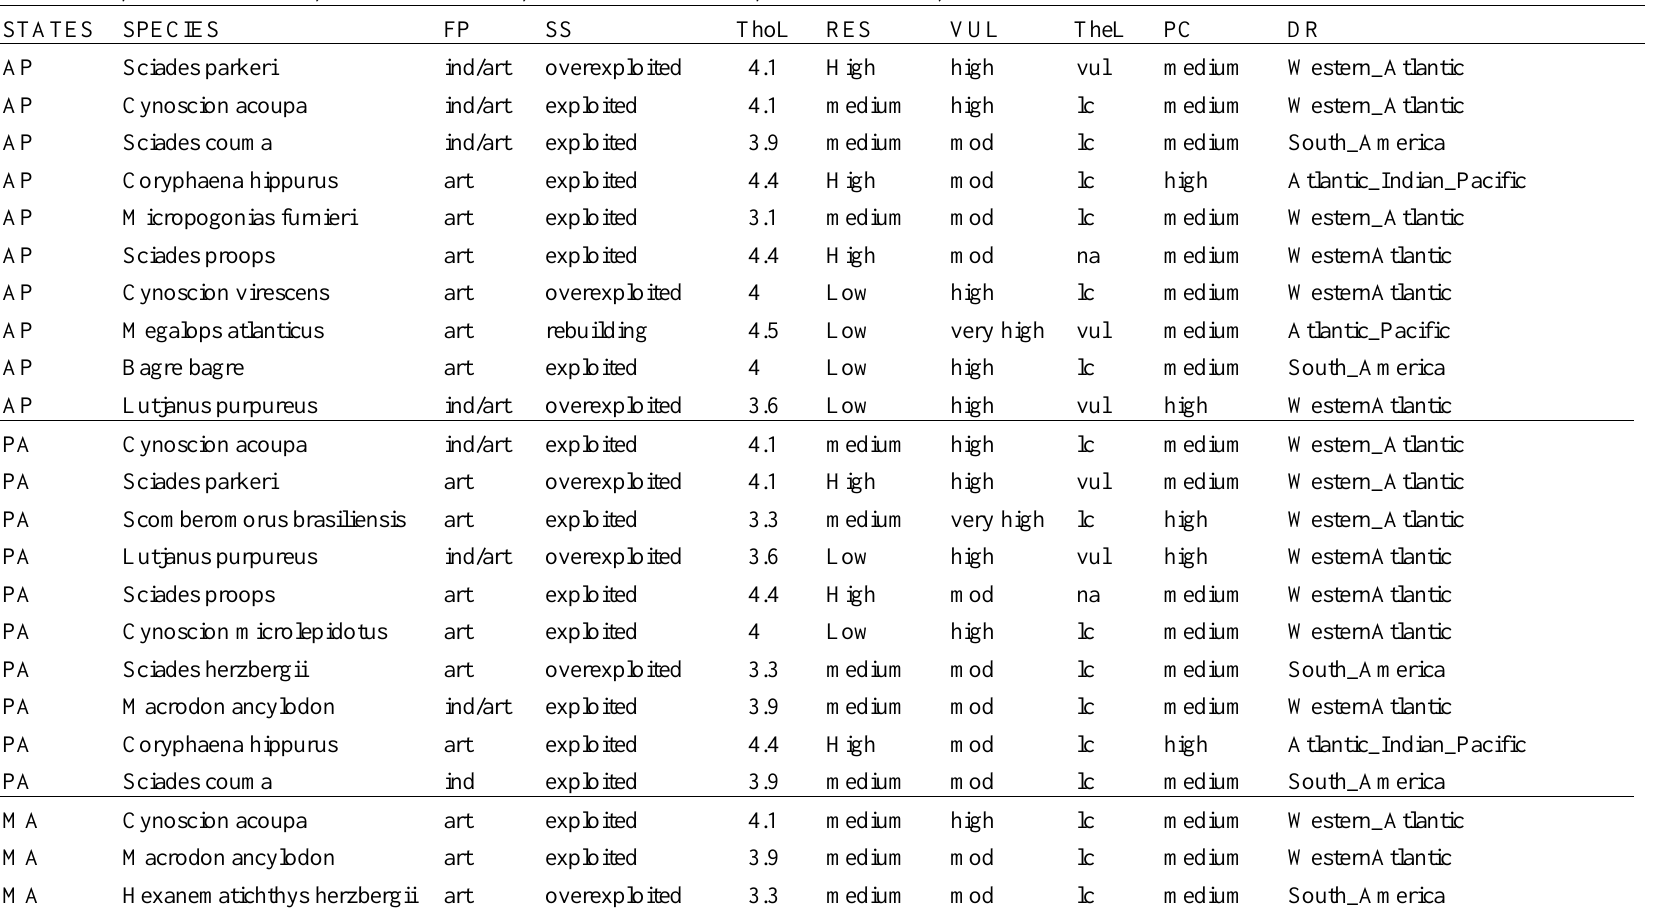
Table A2.1: Target species in all 17 states analyzed along the Brazilian coastline with their vulnerability variables. Information is described for each species of the 10 main fish targets in weight by artisanal and industrial sectors. FP = fishing pressure, SS = stock status, ThoL = trophic level, RES = resilience, VUL = vulnerability, TheL = Threat level, PC = price category, DR = distribution range, art = artisanal, ind = industrial, mod = moderate, vul = vulnerable, lc = least concern, nt = near threatened, not = not threat, dd = data